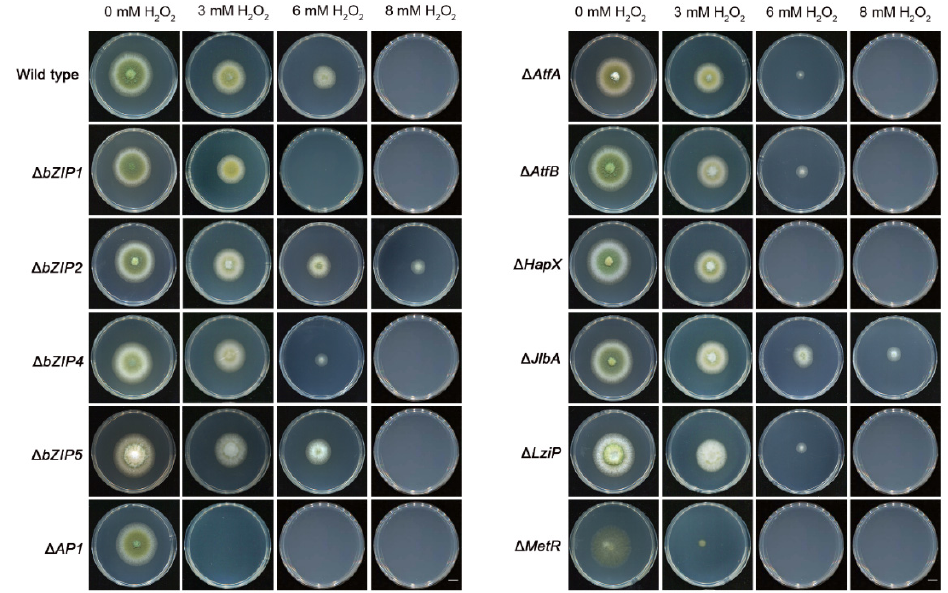
Figure 8. Effects of different concentrations of H 2 O 2 on the growth of Aspergillus flavus strains. Co- nidia of the indicated strains were inoculated on PDA supplemented with H 2 O 2 for 3 days at 30 °C. Bar = 1 cm. Growth inhibition rate (%) of 15 bZIPs mutants under H 2 O 2 stress are shown in Table S3. H 2 O 2 , hydrogen peroxide; PDA, potato dextrose extract agar.